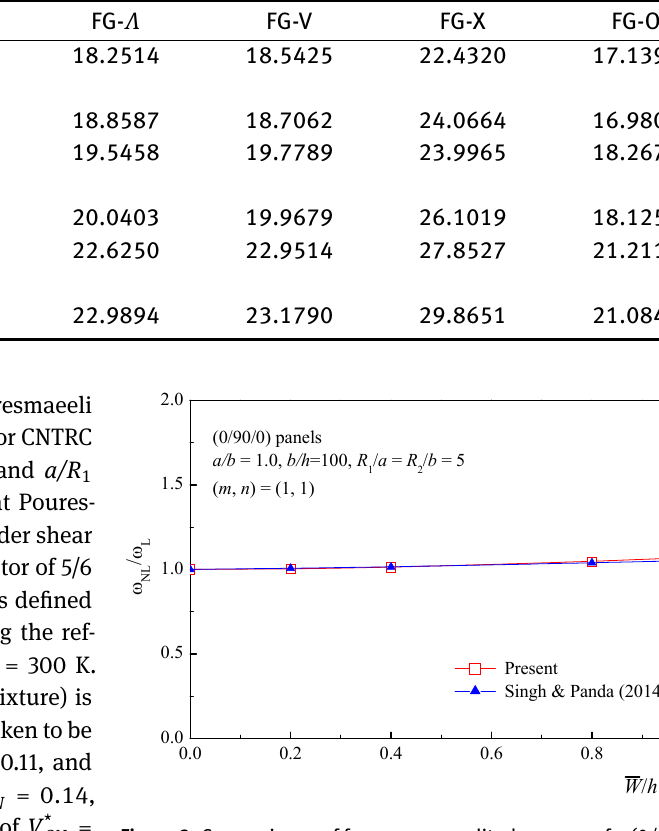
cal, i.e. V G = 0.07. The four FG-GRC panels consist of 10 GRC layers with piece-wise graphene volume fractions, i.e.